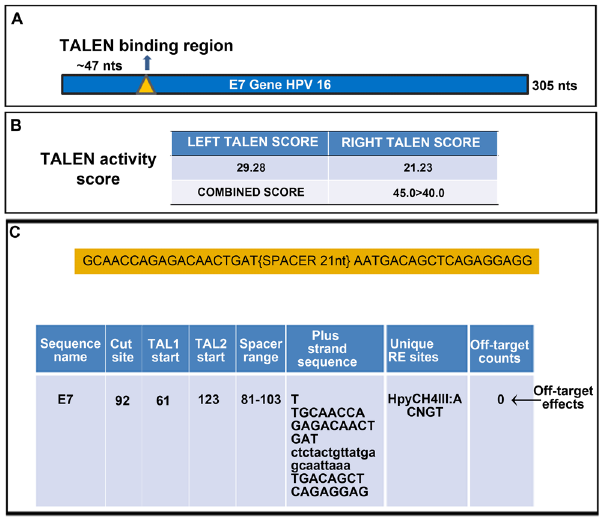
Figure 1. Designing of TALENs targeting the HPV 16 E7 gene. ( A ) Schematic of TALEN binding site on E7 gene. ( B ) TALEN predicted activity using SAPTA software. ( C ) Part of E7 sequence targeted by